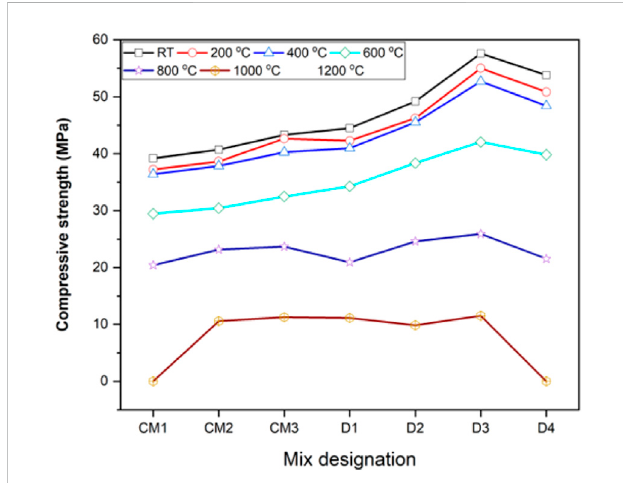
FIGURE 11 Correlation curve between compressive strength and rebound hammer for CM1 mix.